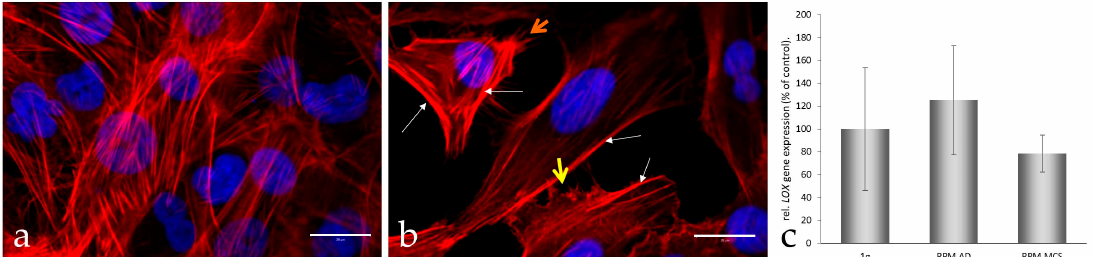
Figure 1. Phase contrast microscopic pictures of UCLA RO82-W-1 1 g -control cells ( a ), and RO82-W- 1 cells cultivated on the Random Positioning Machine (RPM) in slides flasks; ( b ) and T25 cell culture flasks; ( c ) for 24 h. Control cells remained adherent and formed a (sub)confluent monolayer ( a ). In both RPM-samples, some cells remained adherent, while others detached forming 3D spheroids of similar size, thus constituting two distinct cell populations ( b , c ). Scale bars = 100 µm.